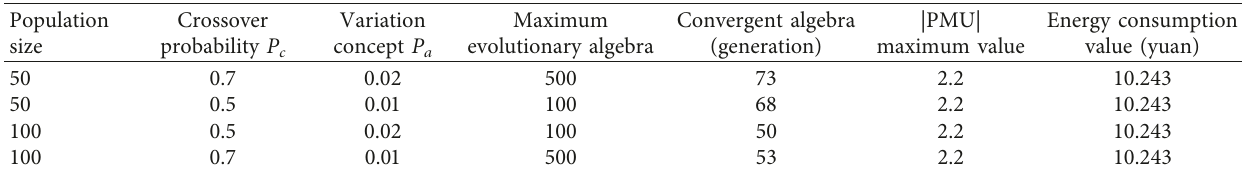
Table 3: Parameter Settings and effects when m � 4 and n � 2.